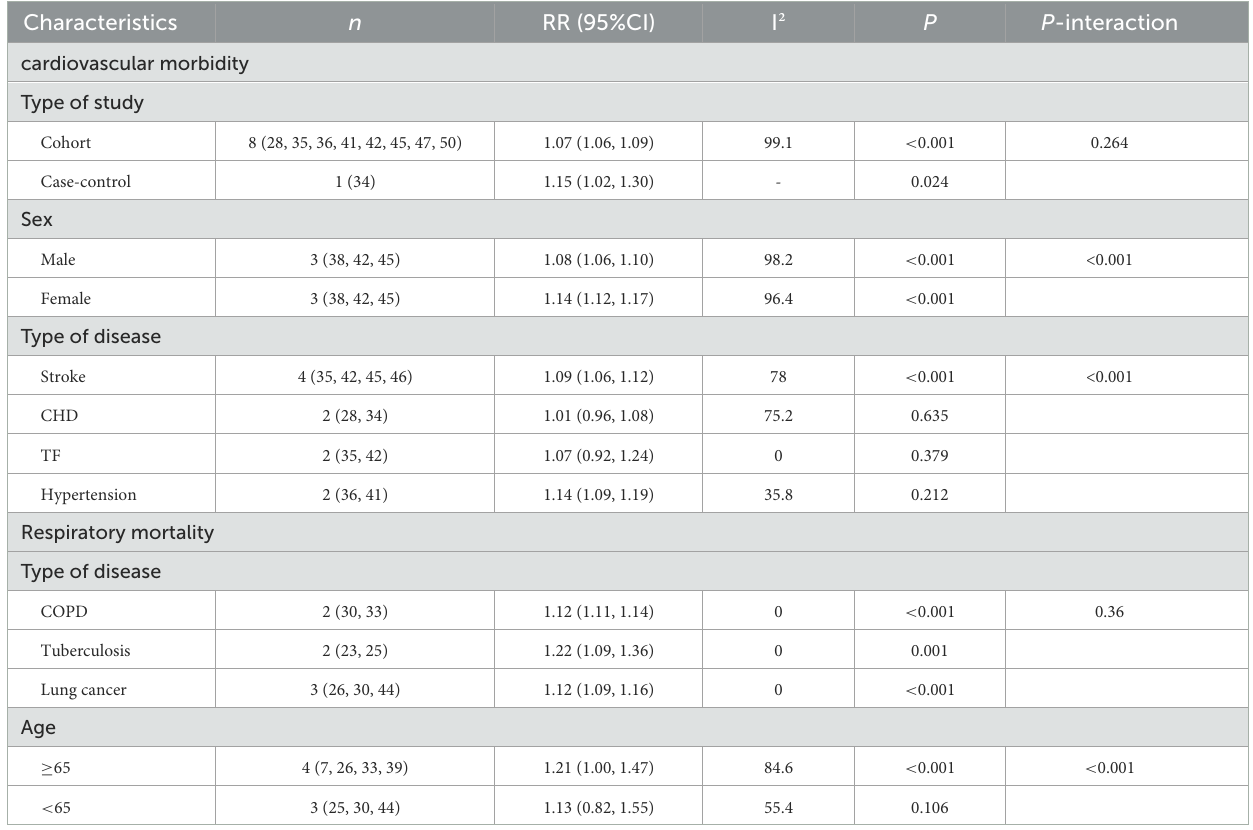
TABLE 2 Subgroup analysis of the effects of PM 2.5 per 10 µ g/m 3 increment on cardiovascular and respiratory